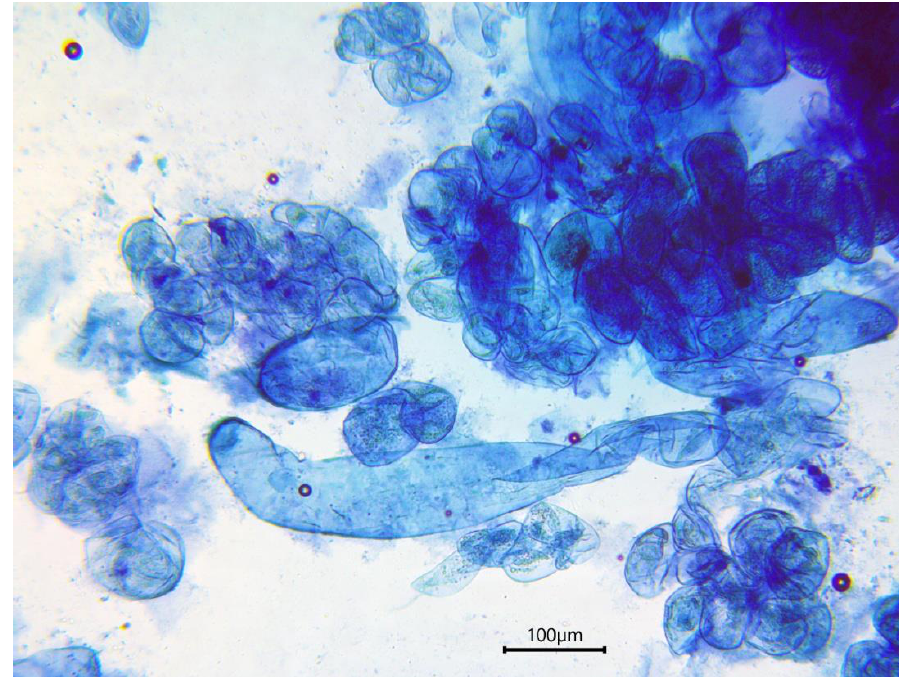
Figure 1. Meristematic and parenchymal types of somatic cells in P. sylvestris callus.